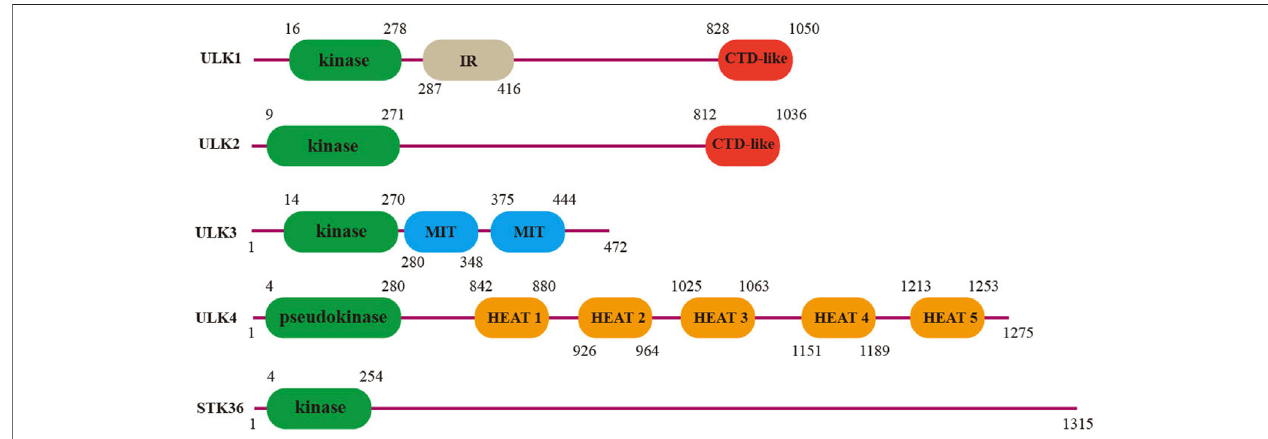
FIGURE 1 | Domain architecture of the human ULK family. Protein interaction domains are annotated as interaction domain (IR), C-terminal domain (CTD) (ULK1 and ULK2), microtubule interacting, and traf fi cking molecule (MIT) (ULK3), and HEAT domains (ULK4).